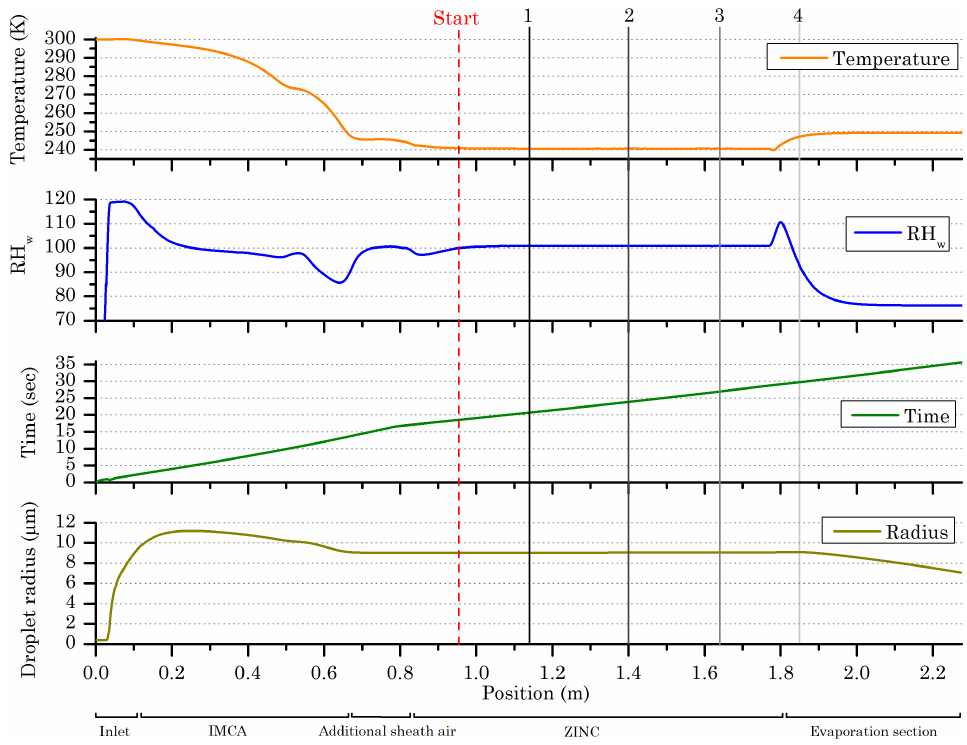
Fig. 2. Experimental conditions along a particle trajectory in the sample air obtained from FLUENT simulations. From top to down the air temperature, relative humidity with respect to water, residence time and calculated droplet size are shown with respect to the vertical location in the experiment. The corresponding parts are labeled at the bottom. The vertical red line indicates the position from where nucleation time was counted. Vertical grey lines numbered with 1–4 show the positions of detection of the frozen fraction.